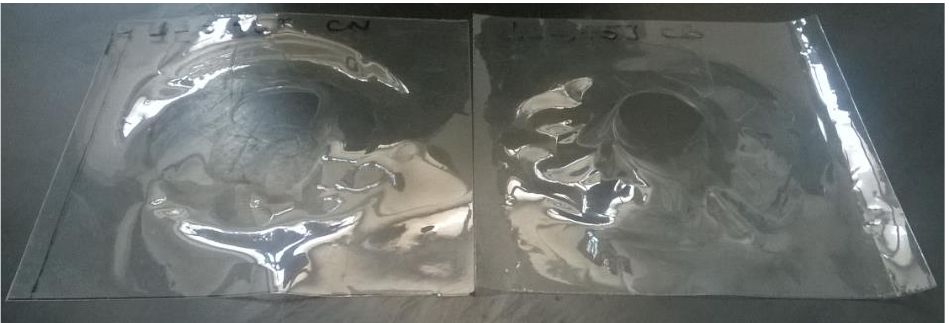
Figure 8. Specimens of ETFE after the impact test at Energy = 3.45 J.